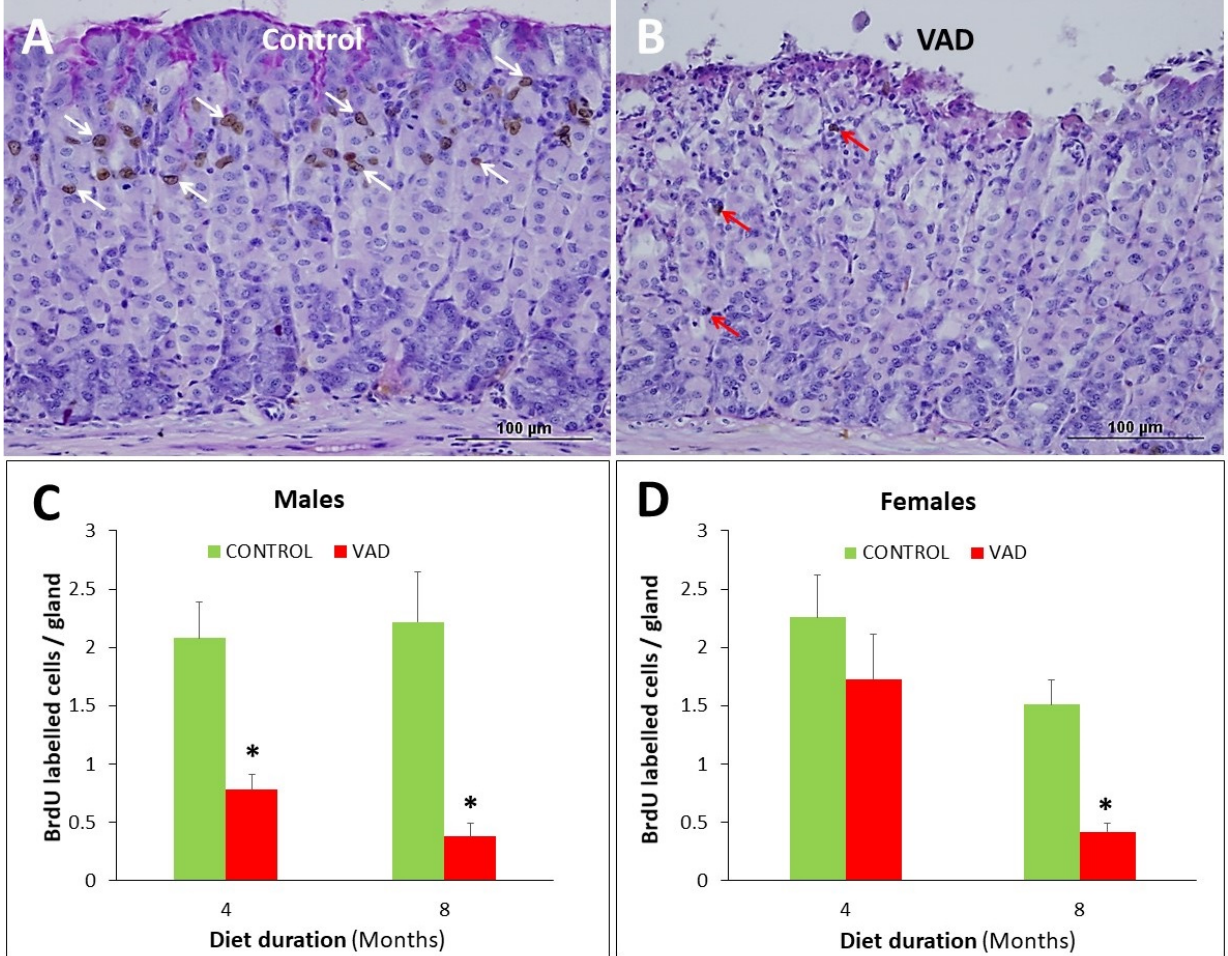
Figure 6. Cell proliferation studies. Gastric mucosal tissue sections from 8-month control ( A ) and VAD ( B ) mice injected with BrdU and probed with anti-BrdU antibodies and counterstained with PAS and hematoxylin. In the control tissue, brownish nuclei of BrdU-labeled cells (white arrows) are seen in the isthmus near the luminal surface. In VAD tissue, only a few BrdU-labeled cells are seen scattered in the mucosa (red arrows). Counts of BrdU-labeled cells in control ( C ) and VAD ( D ) glandular mucosae of male and female mice expressed as average cells per gland ± SE. Scale bars = 100 µm; * p < 0.05.